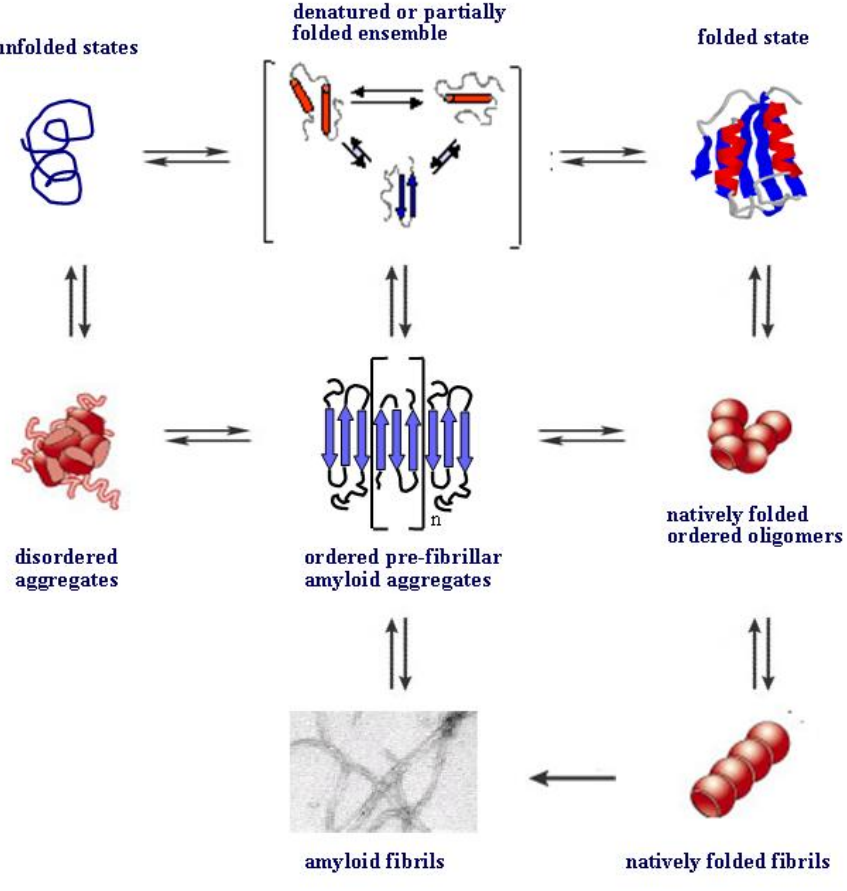
Figure 4. Aggregate nucleation from unfolded or natively folded